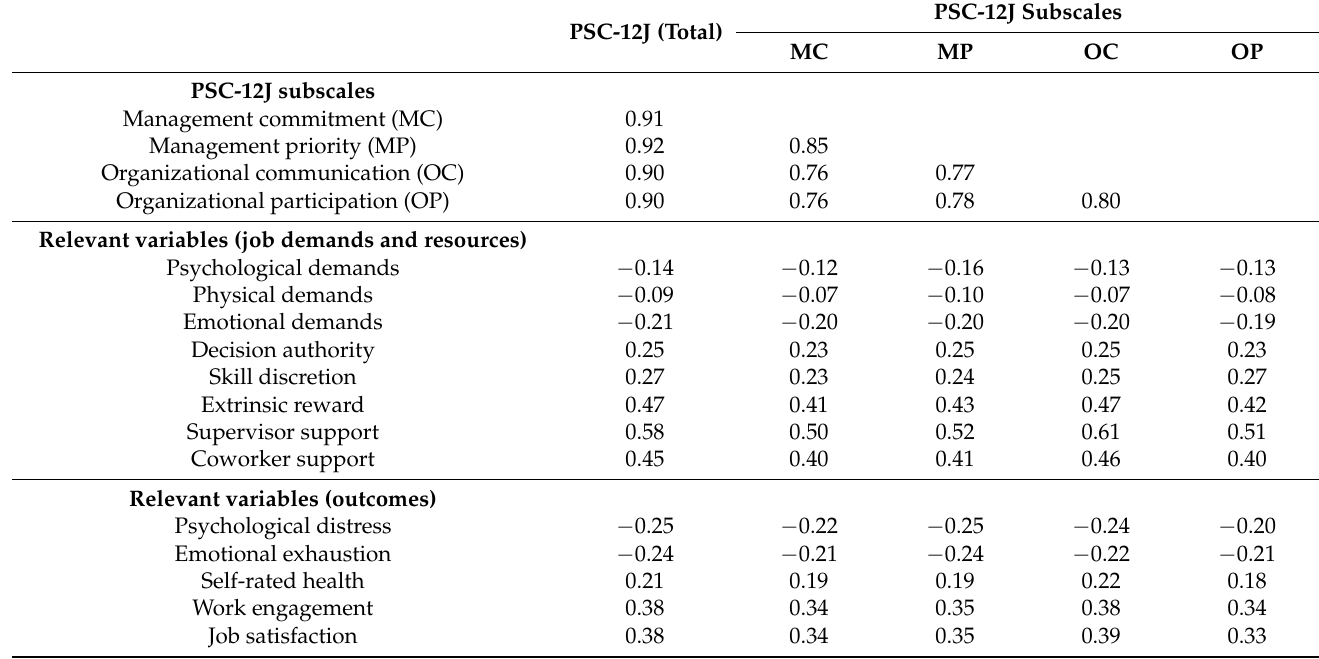
Table 4. Spearman’s rank correlation coefficients of the PSC-12J and its subscales with other relevant variables ( N = 2200) 1 .